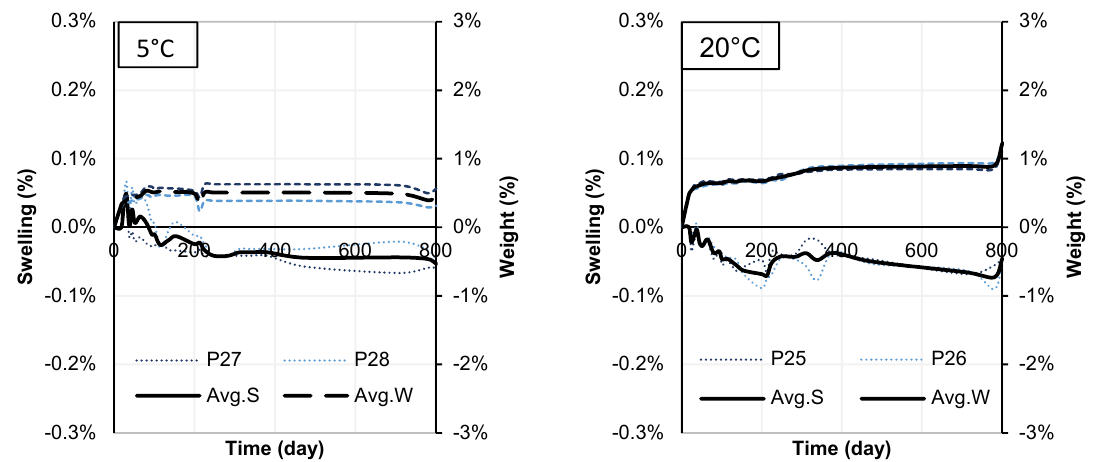
Figure A3. Swelling results in S + C + W1.